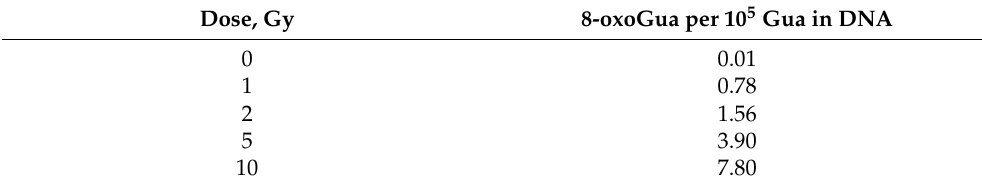
Table 3. Calibration data used to determine the concentration of 8-oxoGua in DNA (data from one of the